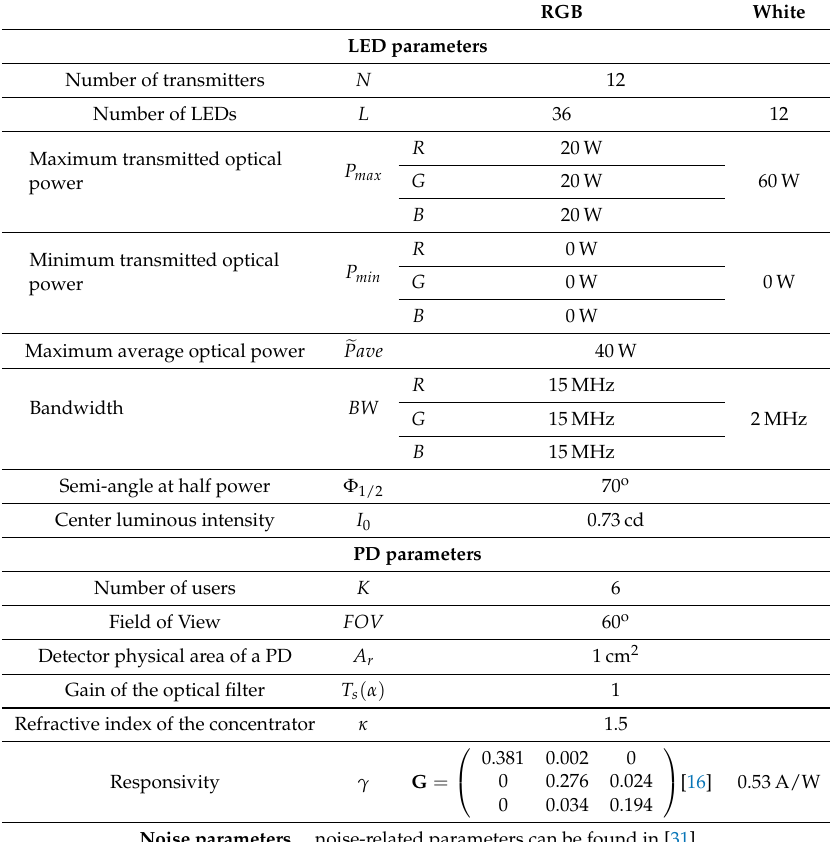
Table 2. Simulation